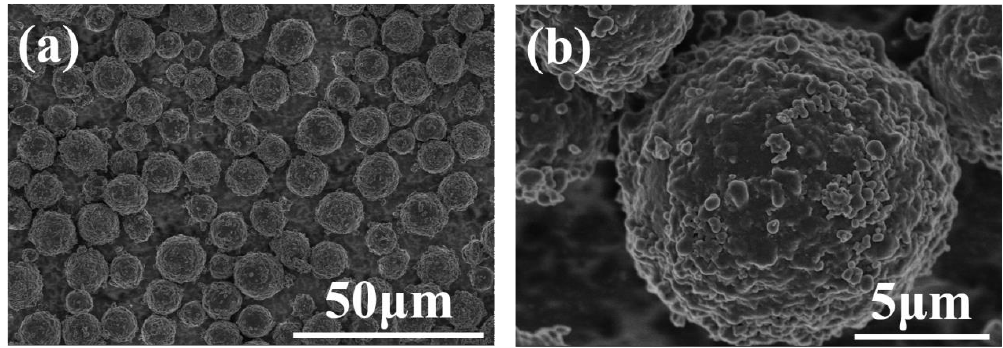
Figure 1. Morphology of mesocarbon microbeads (MCMBs) at ( a ) low and ( b ) high